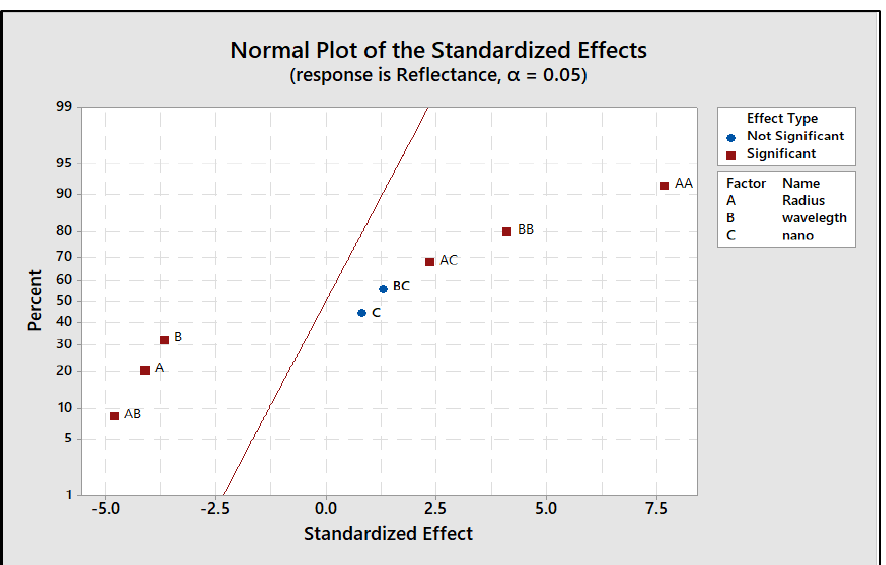
Figure 3. Normal plot of the standardized Si effects.